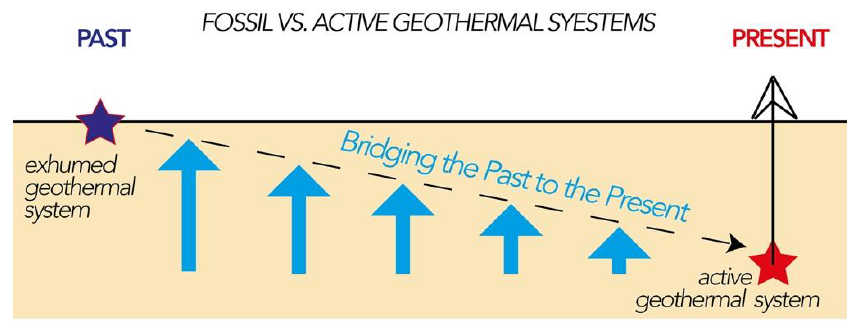
Figure 1. Geological sketch (not to scale) illustrating the conceptual relationships between an analogue, exhumed, geothermal system and its related active geothermal system. The study of the fossil system takes advantage of the relationships between geological structures and hydrothermal mineralization as a key for the understanding of the relationships between geological structures and geothermal fluid flow in the active system at depth.